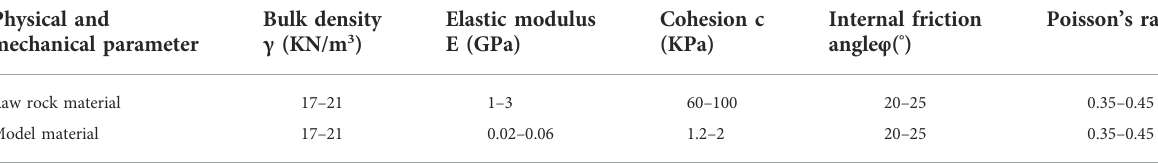
TABLE 1 Value range of material, physical, and mechanical parameters.